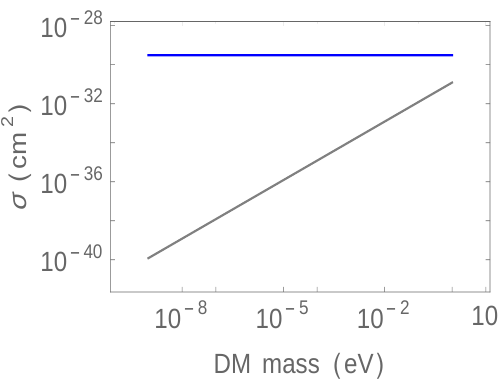
Figure 2. Cross-section vs. mass of DM. Blue line represents cross-section for m (cid:23) = 0 : 1 eV, c (3) = (cid:3) = 0 : 5 GeV (cid:0) 1 for interaction (3) under Topology I. Grey line represents the required cross- l section to induce 1% suppression of incoming